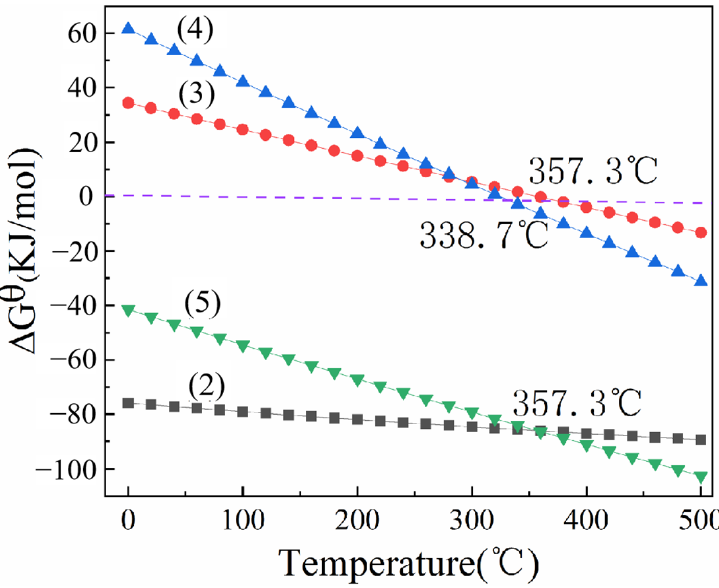
Figure 4. Relationships between Gibbs free energy of the reaction and temperature.